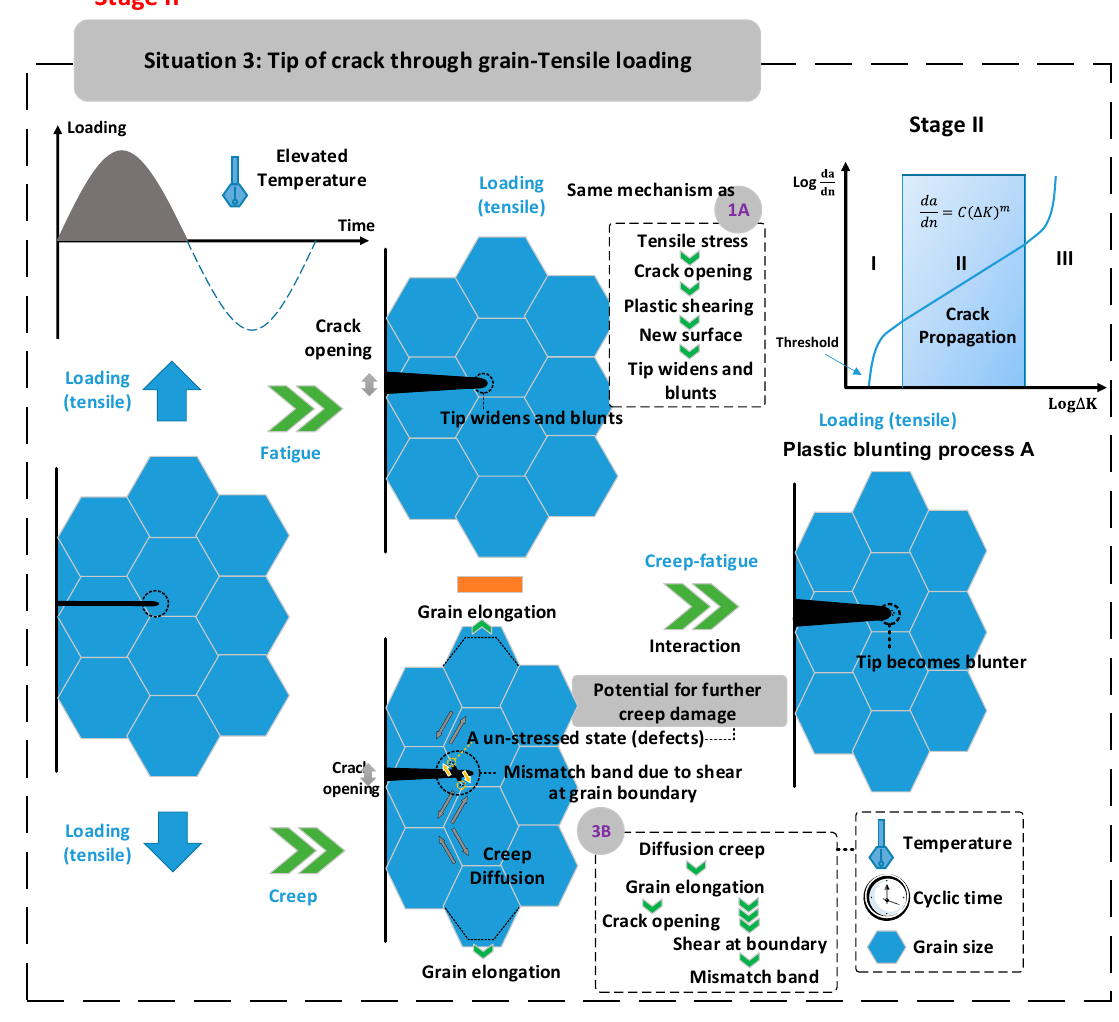
Figure 16. Crack tip through grain boundary—Tensile loading.